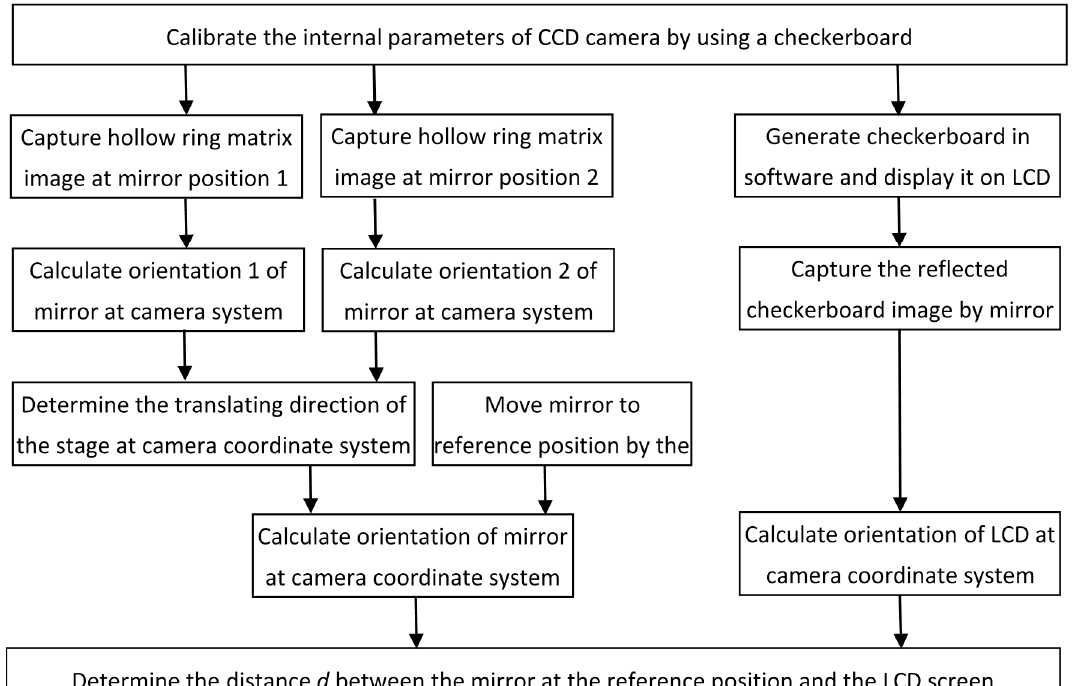
Figure 1. Flowchart of distance calibration using a moving stage in the direct phase measuring deflectometry (DPMD)